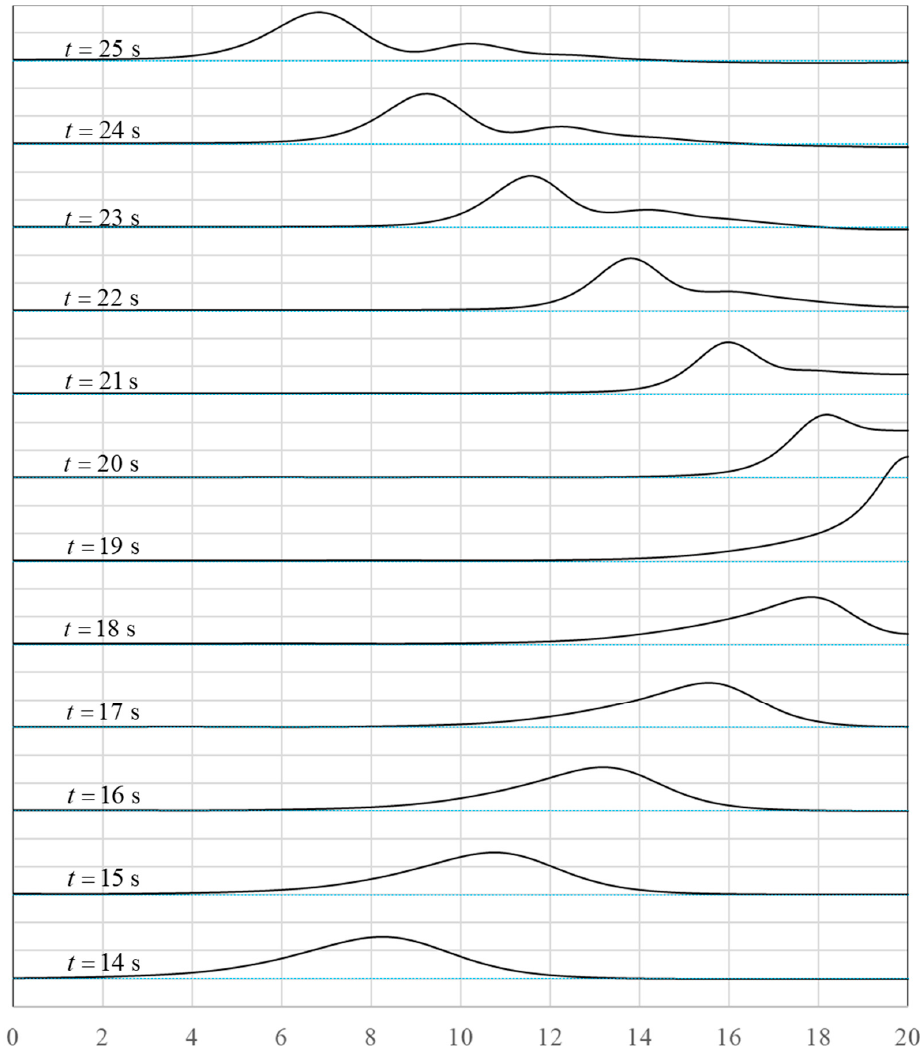
Figure 3. Snapshots of the free surface profiles in the test case of solitary wave reflection after running up a slope. Black solid lines are the free surface. The blue dash lines are the static water level. The height of each cell is 0.05 m.